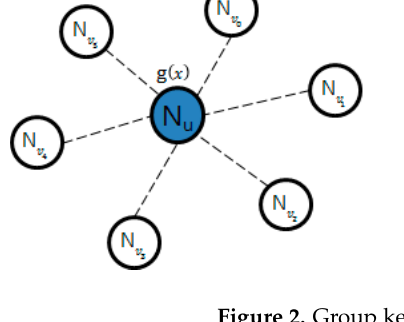
Figure 2. Group key generation and encryption.